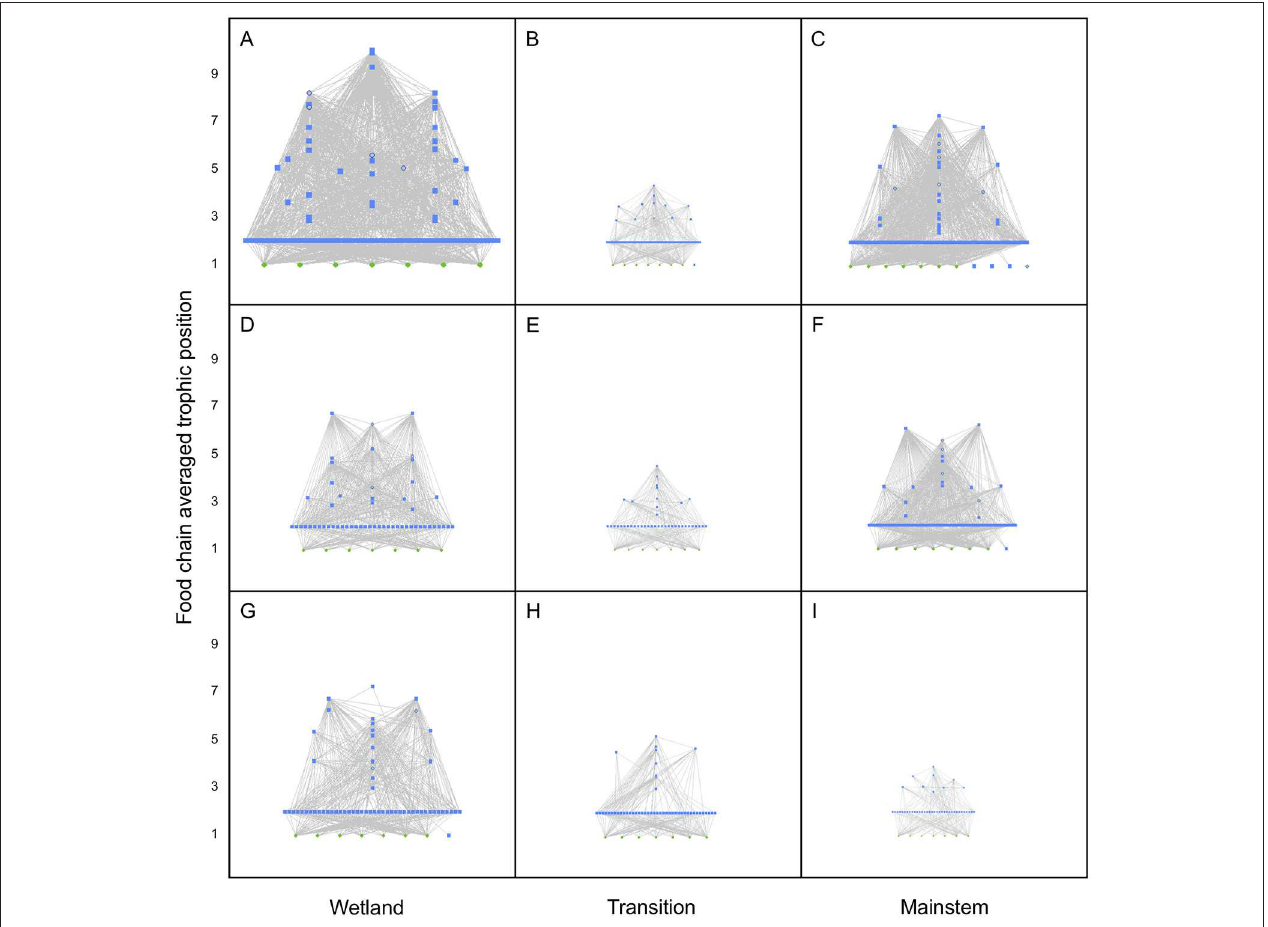
FIGURE 2 | Metawebs for the Portobello Creek wetland complex (Wetland), the Jemseg River connecting the wetland to the mainstem (Transition) and the Saint John/Wolastoq River (Mainstem) in (A–C) June, (D–F) September, and (G–I) December of 2016. Trophic position for each node was calculated as the food chain-averaged value for that consumer or resource. For nodes, green squares depict producers, blue squares depict consumers, and open blue circles depict cannibalistic consumers. The size of nodes and thickness of links are scaled to the maximum trophic position for each food